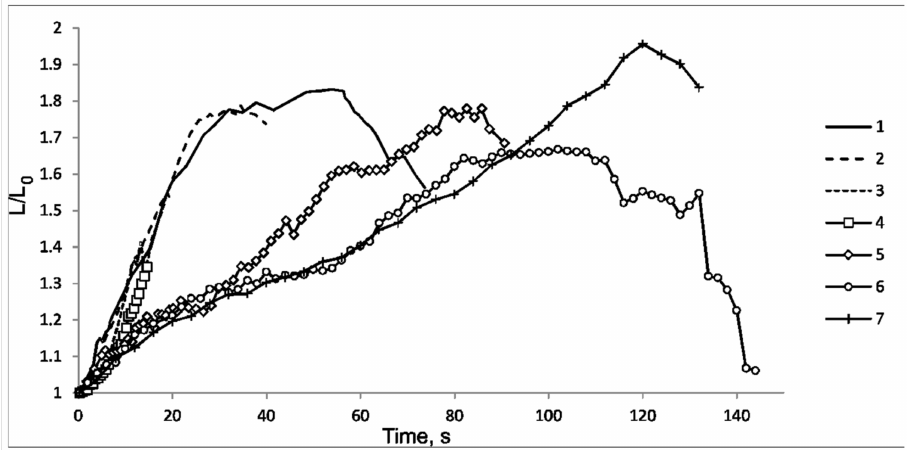
Figure 6. Size of particles, L/L 0